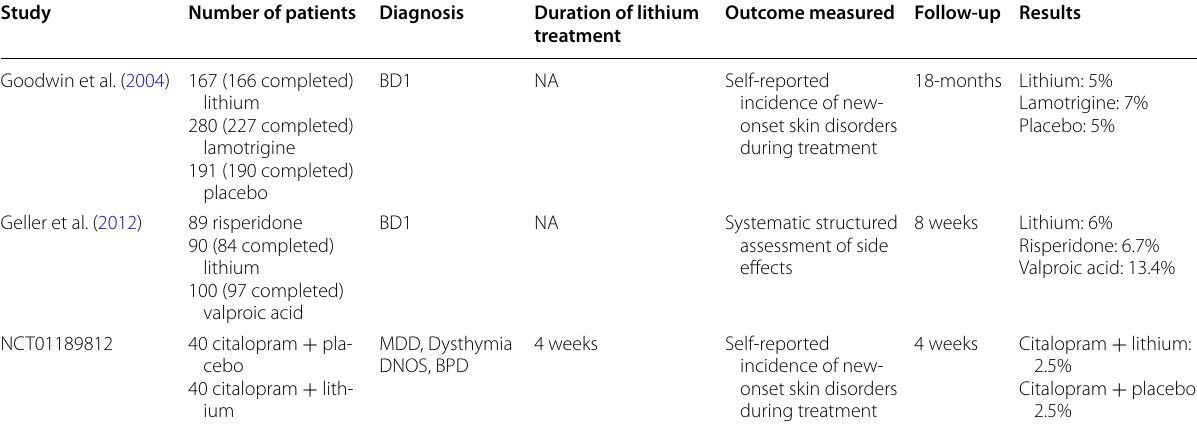
NA not available, BD bipolar disorder, BD1 bipolar disorder type 1, MDD major depressive disorder, DNOS depression not otherwise specified, BPD borderline personality